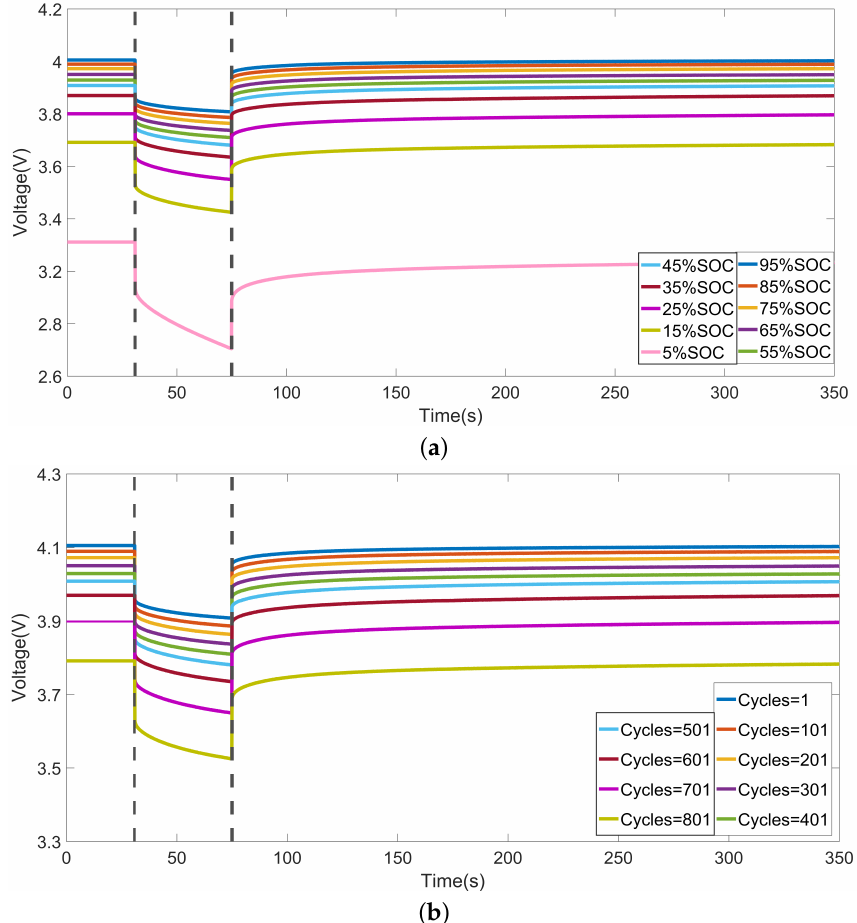
Figure 5. Output voltage of the instantaneous discharge of battery No. 001: ( a ) at different SOCs; ( b ) at different cycle